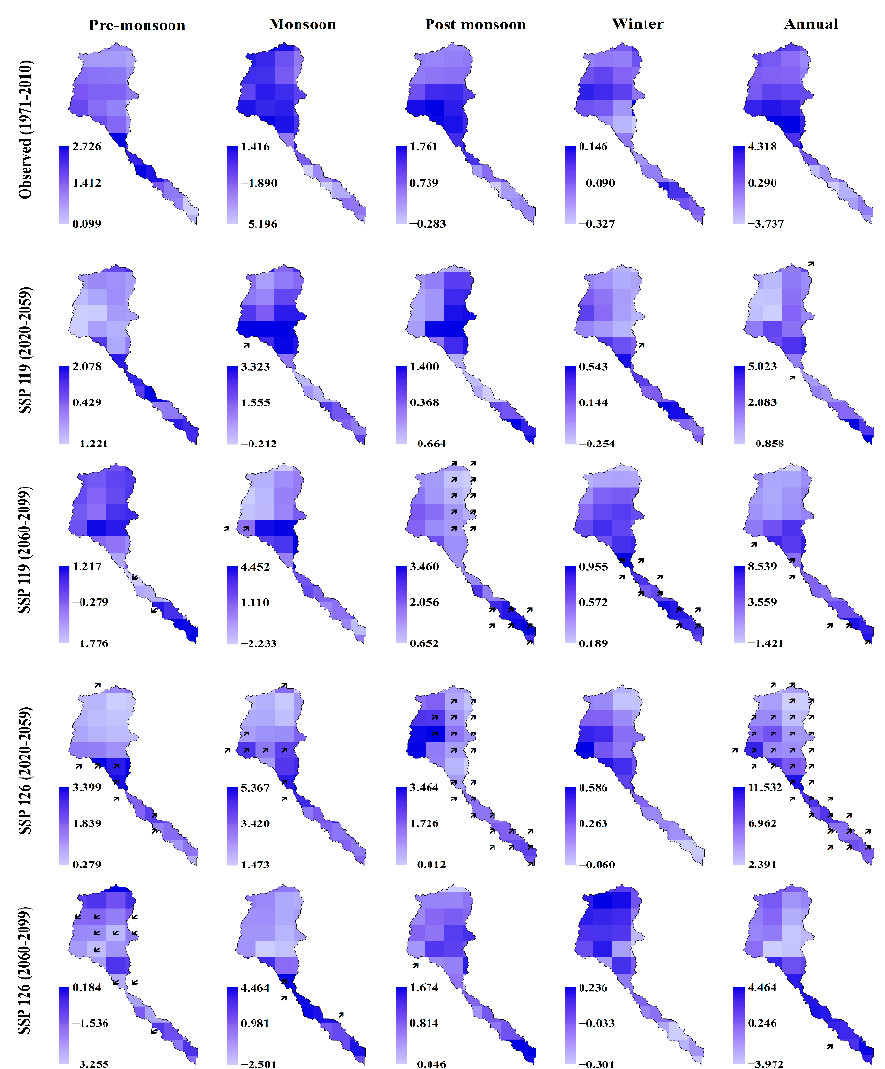
Figure 7. Spatial distribution of trend (significant at 95% confidence level) and magnitude in the seasonal and annual series of water availability during the observational and future period (tilted upward arrow denotes significant increasing trend and vice versa).